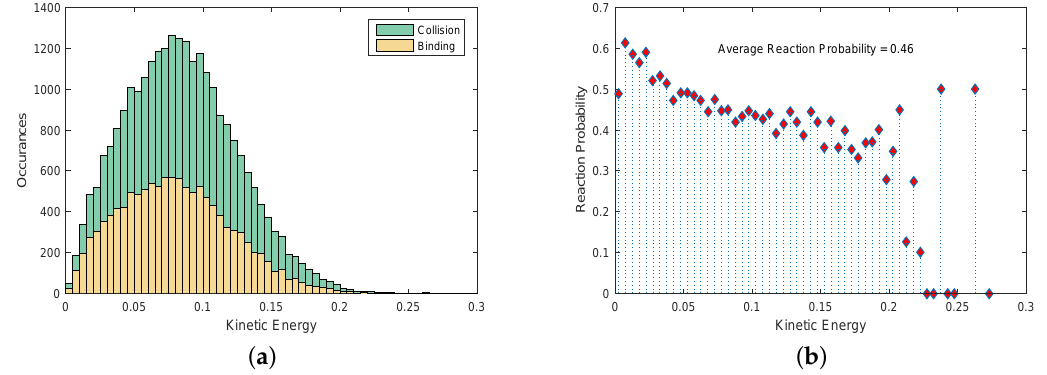
Figure 15. Reactions in the system. ( a ) Distribution of collision and binding events across the collision energy spectrum; ( b ) reaction probability distribution across the collision energy